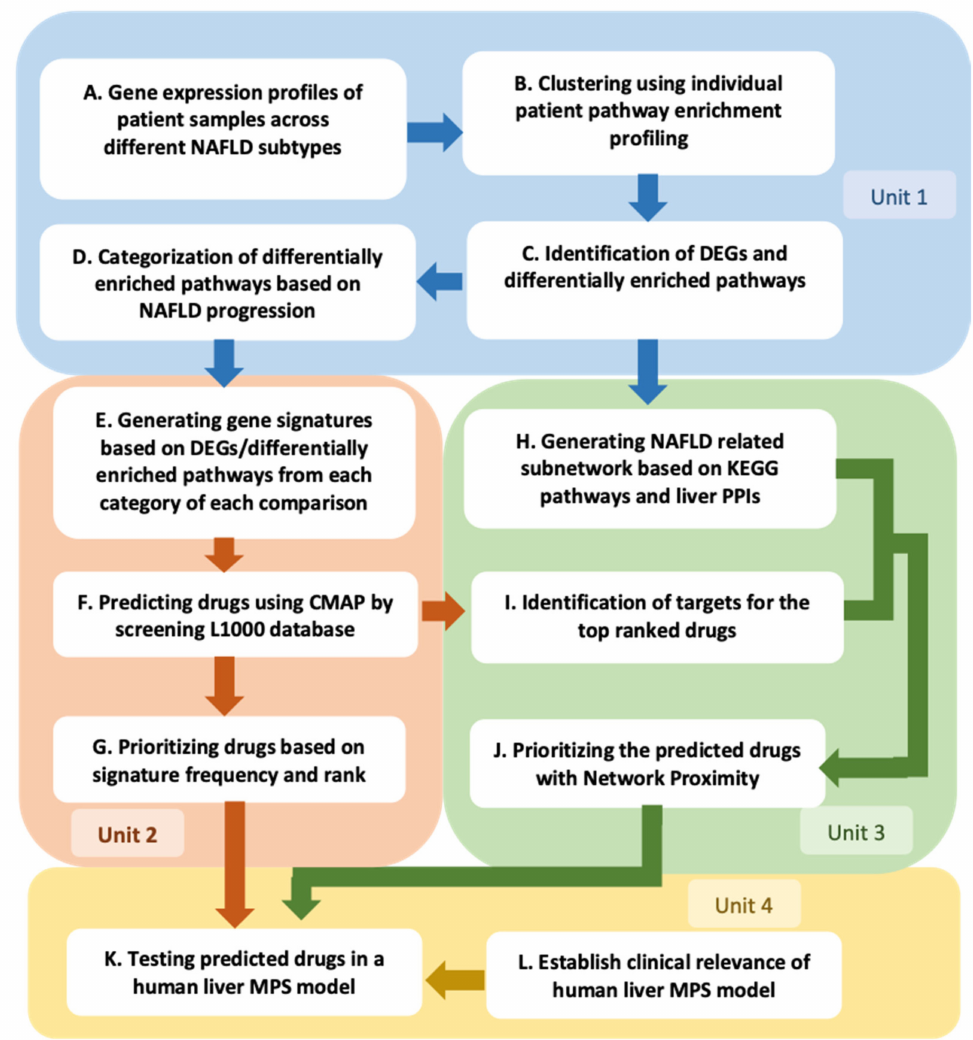
Figure 1. Workflow associating NAFLD subtypes with gene expression signatures to computationally predict and prioritize drugs for testing in a patient-derived microphysiological model of disease progression. Four integrated units are shown, each comprised of a set of steps detailed in the Methods and Results. Unit 1A–D identifies and clusters individual patient hepatic gene expression and enriched pathway profiles associated with clinical subtypes and categorizes the differentially enriched pathways among these clusters (Figures 2 and 3; Tables S2 and S3, and Data files S1 and S2) within our current framework of NAFLD pathophysiology [2,5]. The rationale is presented in the Results for using clusters based on individual patient pathway enrichment profiles as an alternative to the clinical classifications (compare Figure 3, Figures S1 and S2) for determining both differentially expressed genes and enriched pathways between different stages of disease progression. Unit 2E–G generates disease progression-based gene expression signatures (Table S4; Data file S3) and, using the Connectivity Map (CMap) databases, identifies drugs that can normalize these signatures (Table 1 and Table S5; and Data files S4 and S5). The highly integrative Unit 3 H-J maps known protein targets of the predicted drugs from Unit 2 to an NAFLD subnetwork encompassing protein targets from the gene expression analysis within Unit 1 (Figure S6; Table S7, and Data file S6). A network proximity score is then calculated that helps prioritize candidate drugs identified by CMap analysis for